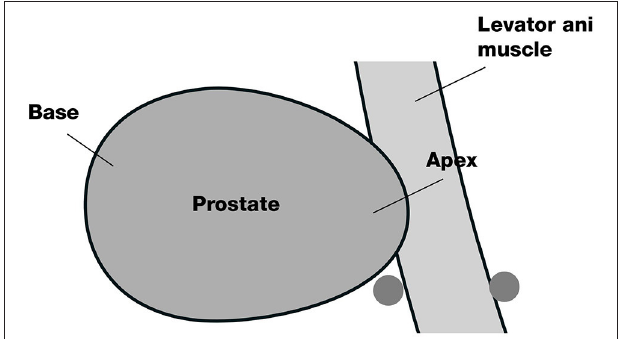
FIGURE 2 | Diagram of the location of the perineal nerve block: The 2 grey dots are the block sites.